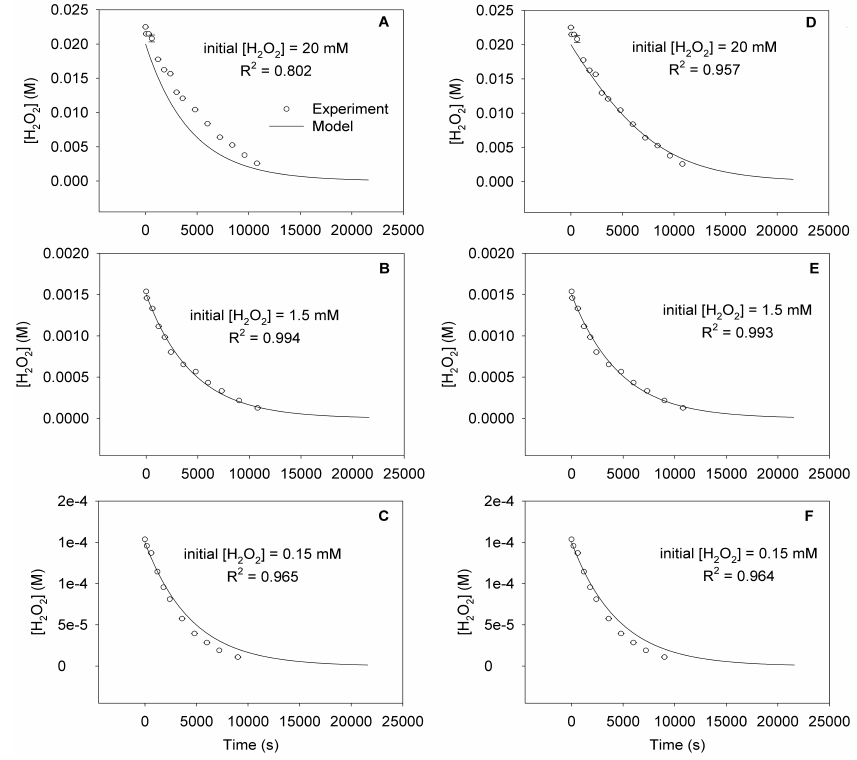
Fig. 4. Real-time profiles of 254nm UV photolysis decay of H 2 O 2 (where initial concentrations are 0.15, 1.5, and 20mM) without light- absorption correction ( A, B , and C ) and with the correction ( D, E , and F ). The correction was made by multiplying the transmittance by the H 2 O 2 photolysis decay rate constant, where –log (transmittance) = 18.4 × 0.80 × [H 2 O 2